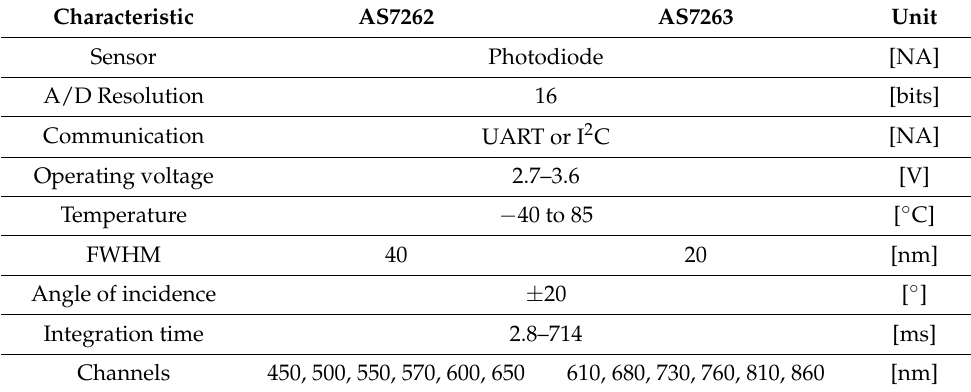
Figure 4. Architecture of light sensing and signal processing. Table 1. Characteristic of AS7262,